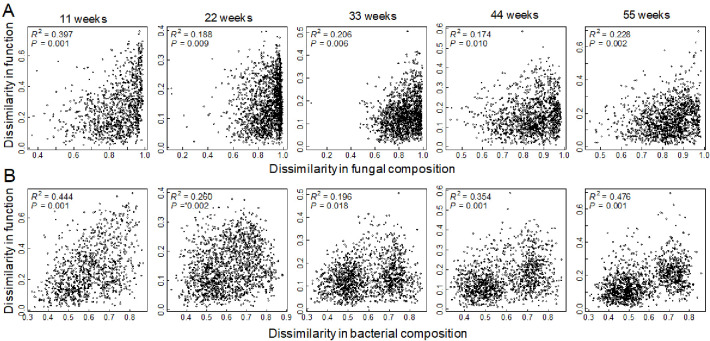
Mantel correlation tests associating the dissimilarity in ecosystem functioning and the dissimilarity in (A) the fungal and (B) the bacterial community compositions at each of the five sampling times.Dissimilarity was calculated using Euclidean distance.